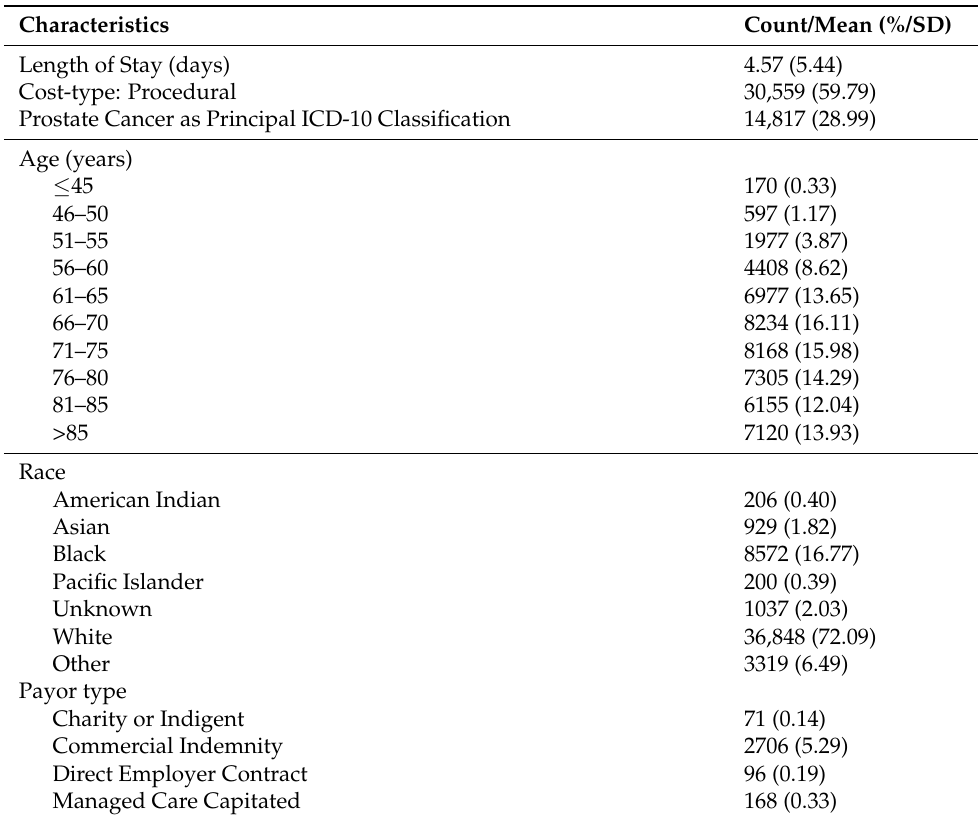
Table 1. Descriptive statistics (counts/means and percentages/standard deviations) of patient characteristics, competing resources, and the outcome